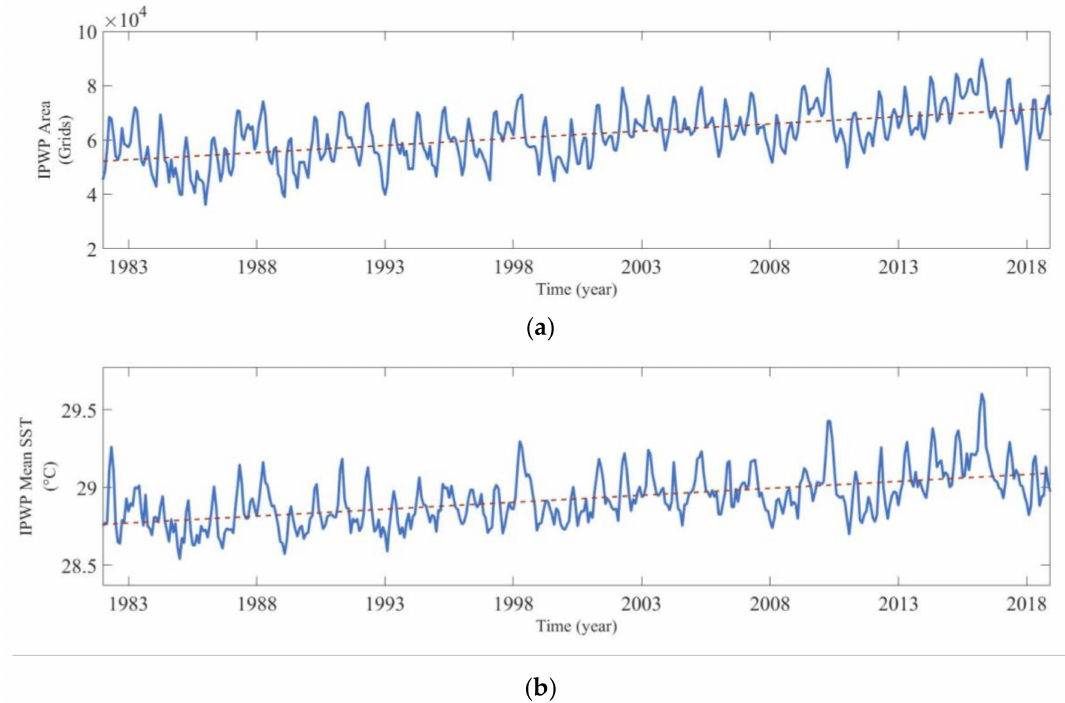
Figure 1. Time series of the Indo-Pacific Warm Pool (IPWP) size ( a ) and of the IPWP mean Sea Surface Temperature (SST) ( b ) with their trend line (red dotted line)